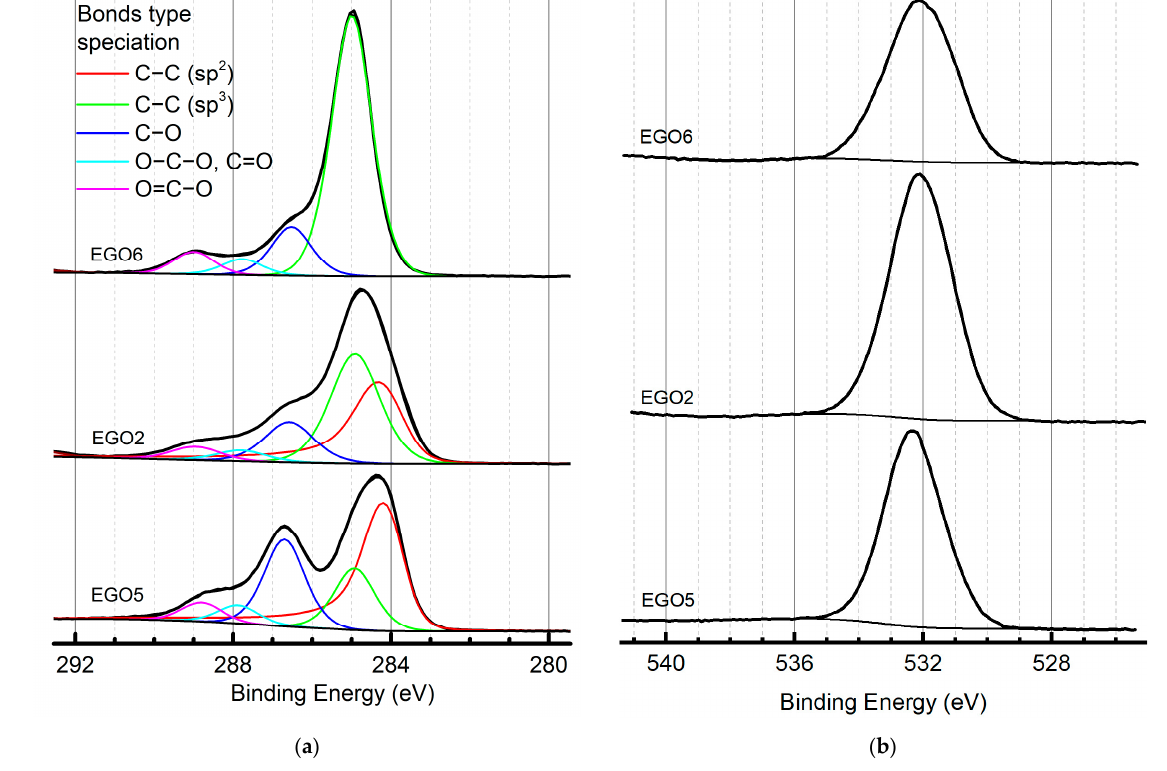
Figure 7. XPS spectra of the prepared EGO samples: ( a ) C 1s; ( b ) O 1s. Table 3. Binding energies and fraction compositions of components (at. %) in C 1s high-resolution XPS spectra on the surface of the samples.